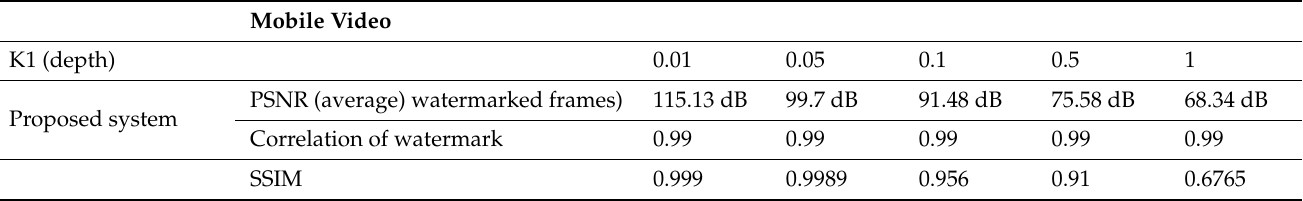
Table 1. The effect of the depth of the